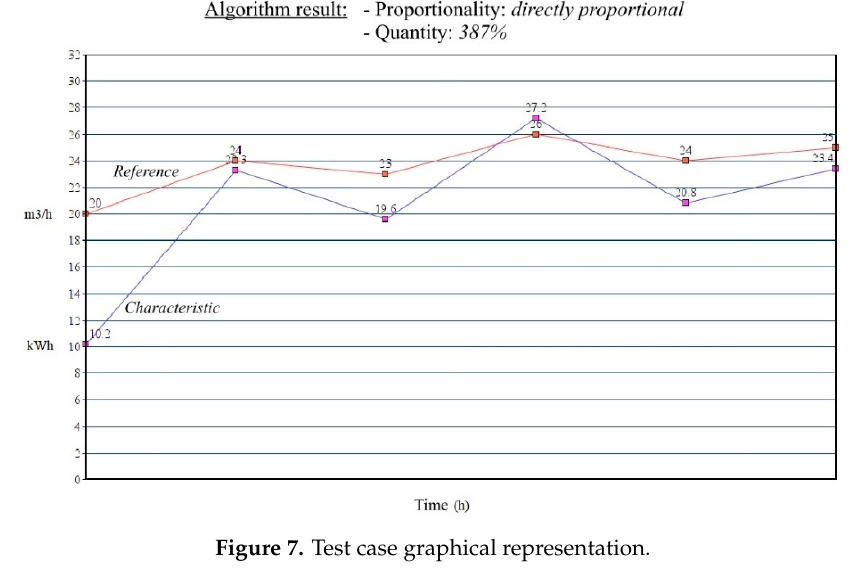
Figure 7. Test case graphical representation.